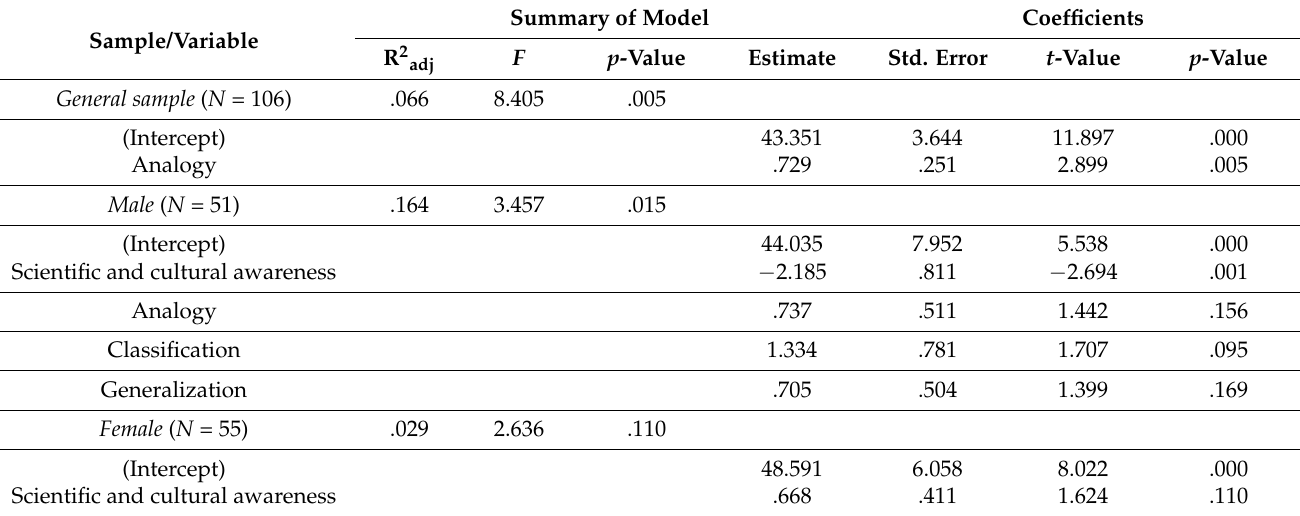
Table 5. Best predictor regression models for Acceptance subscale of ISS.